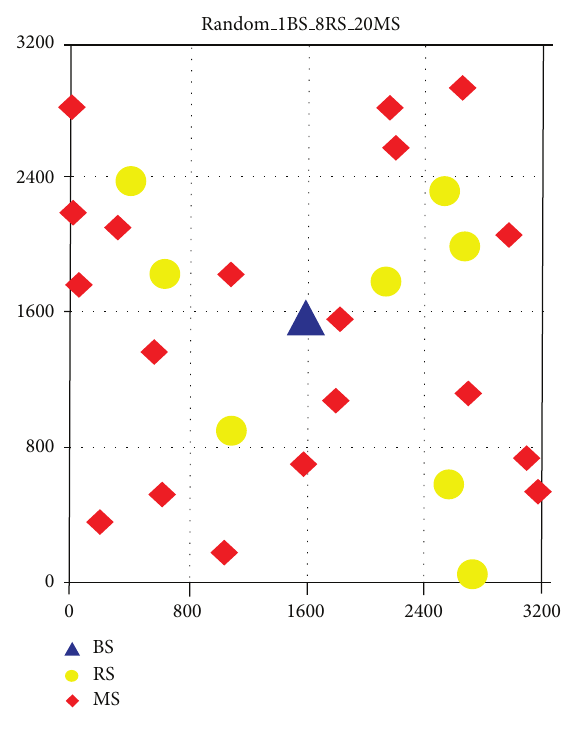
Figure 6: Random topology example.